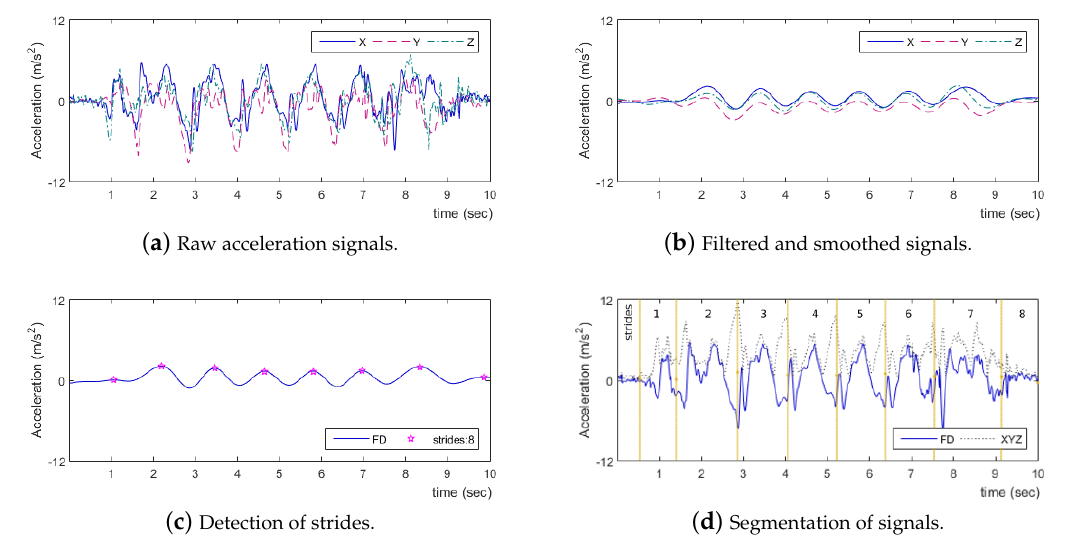
Figure 3. Data flow in strides segmentation process. Raw acceleration signals acc X , acc Y , accZ ( a ) are filtered and smoothed ( b ). Then, strides are estimated ( c ) and used for segmenting forward-direction FD and acceleration magnitude vector XYZ signals ( d